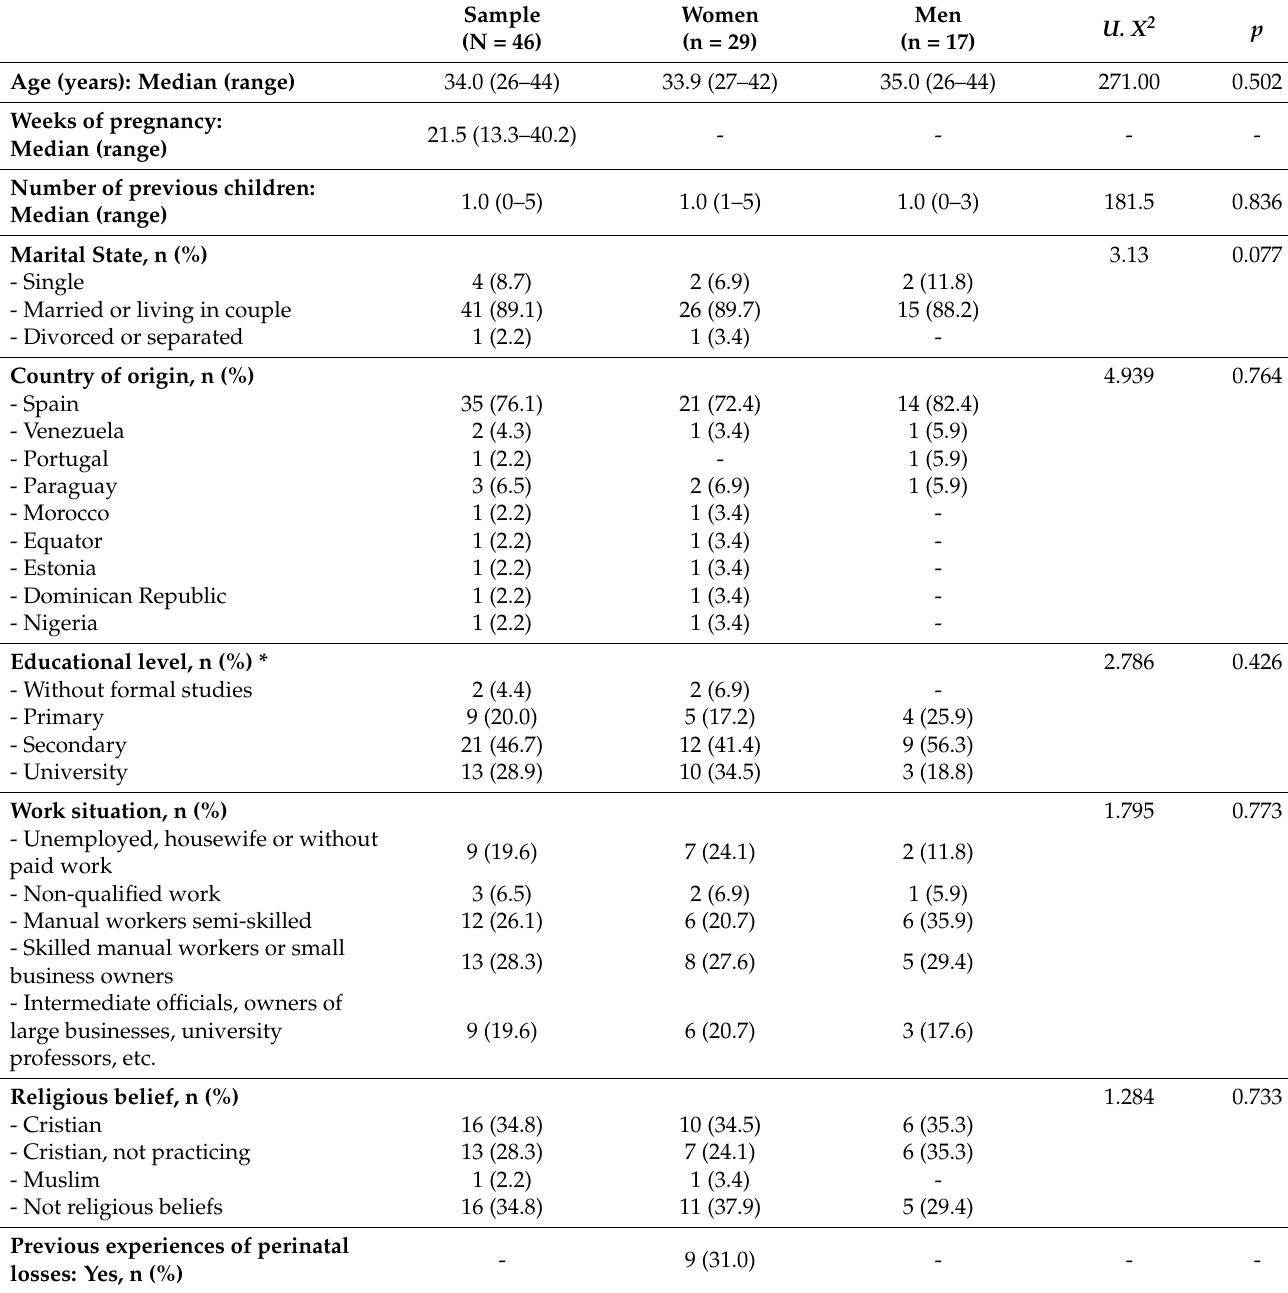
Table 1. Sociodemographic and clinical data of the sample (N =